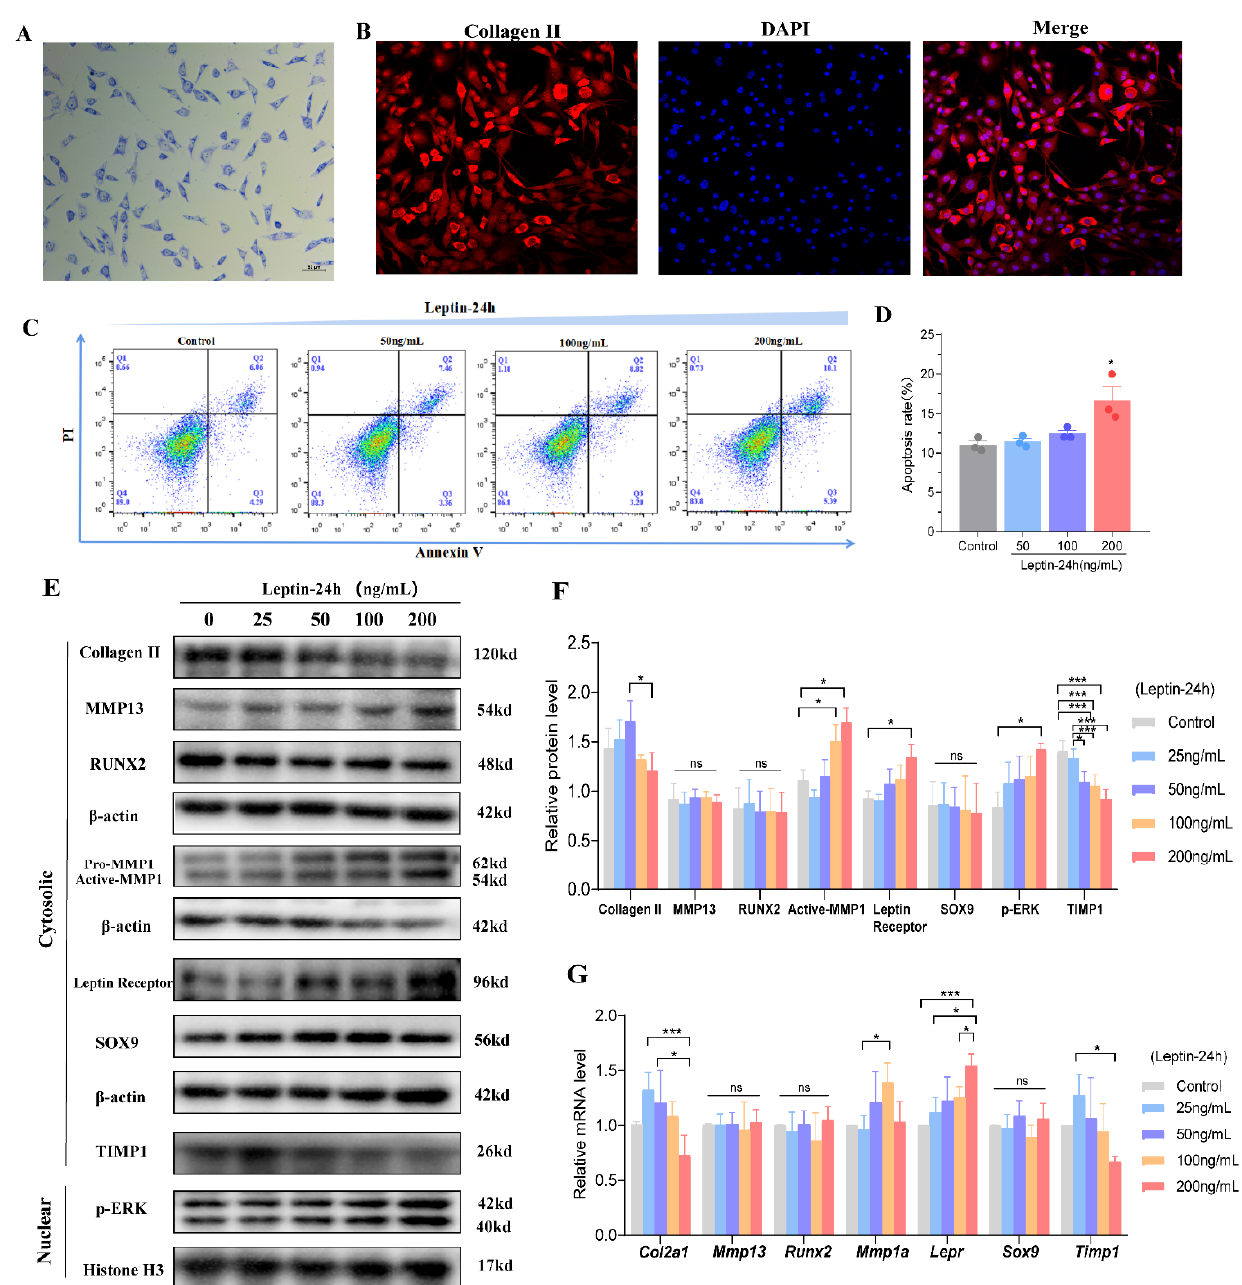
Figure 5. Expression of key cartilage ‐ related factors under different doses of leptin in vitro. ( A ) Toluidine blue staining of chondrocytes (×200 magnification). ( B ) Representative collagen II immunofluorescent staining (×200 magnification). ( C ) Detection of apoptosis by flow cytometry ( n = 3, chondrocytes obtained from three separate repeated experiments). ( D ) Statistical analysis of apoptosis rate. ( E ) Representative western blot bands of the expression of p ‐ ERK in the nucleus and collagen II, MMP13, RUNX2, MMP1, Leptin Receptor, SOX9, and TIMP1 in the cell cytoplasm induced by leptin in vitro ( n = 3, chondrocytes obtained from three separate repeated experiments). ( F ) Statistical analysis of the relative protein levels. ( G ) Relative mRNA expression of cartilage ‐ related factors under different doses of leptin treatment for 24 h in vitro ( n = 4, chondrocytes obtained from four separate repeated experiments). Results are expressed as mean ± SD. ns not significant, * p < 0.05, *** p < 0.001.